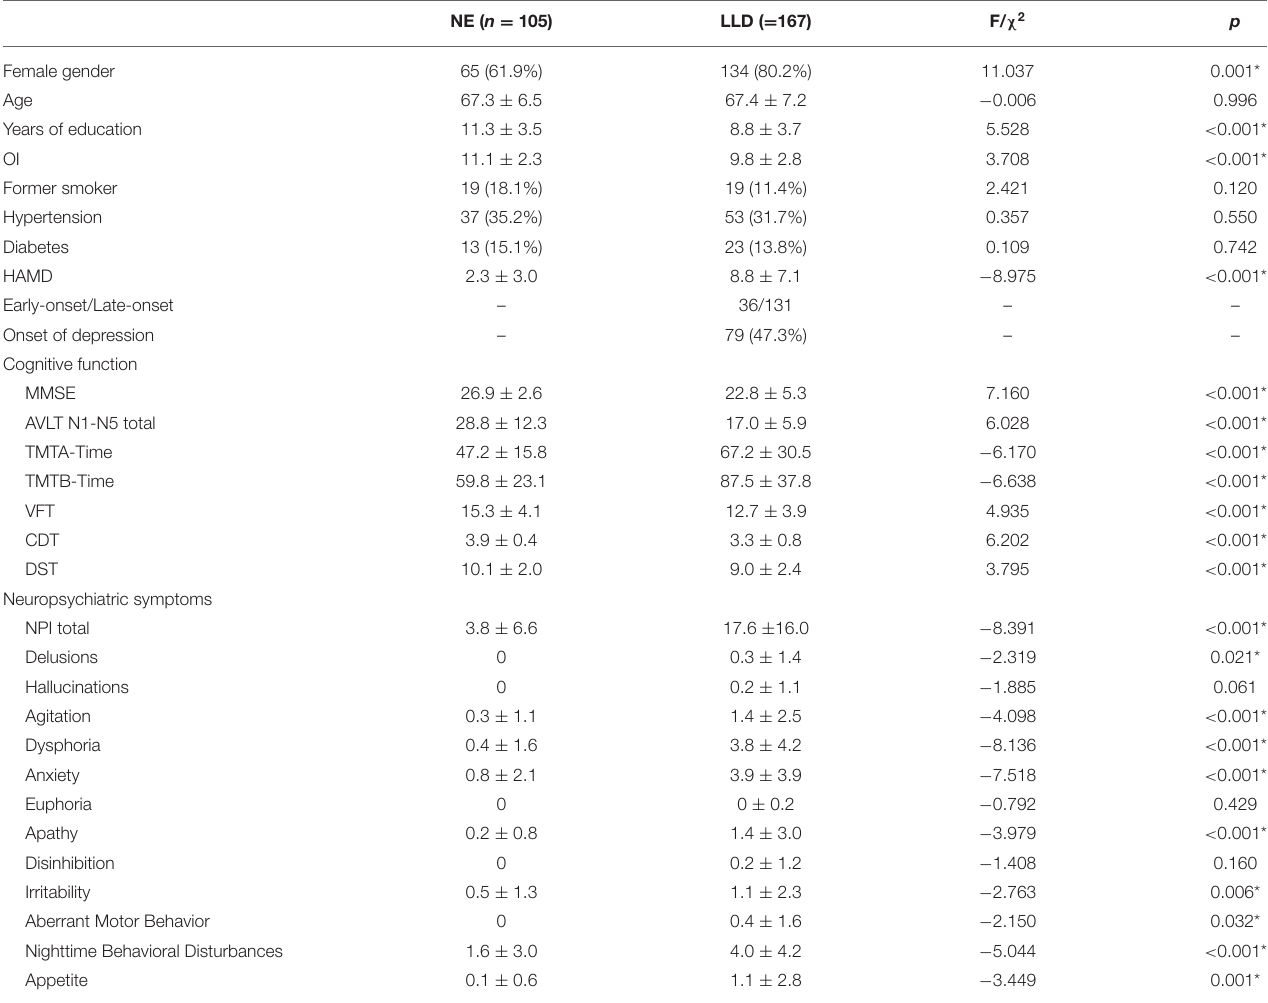
TABLE 1 | Demographic data, clinical information, cognitive and olfactory